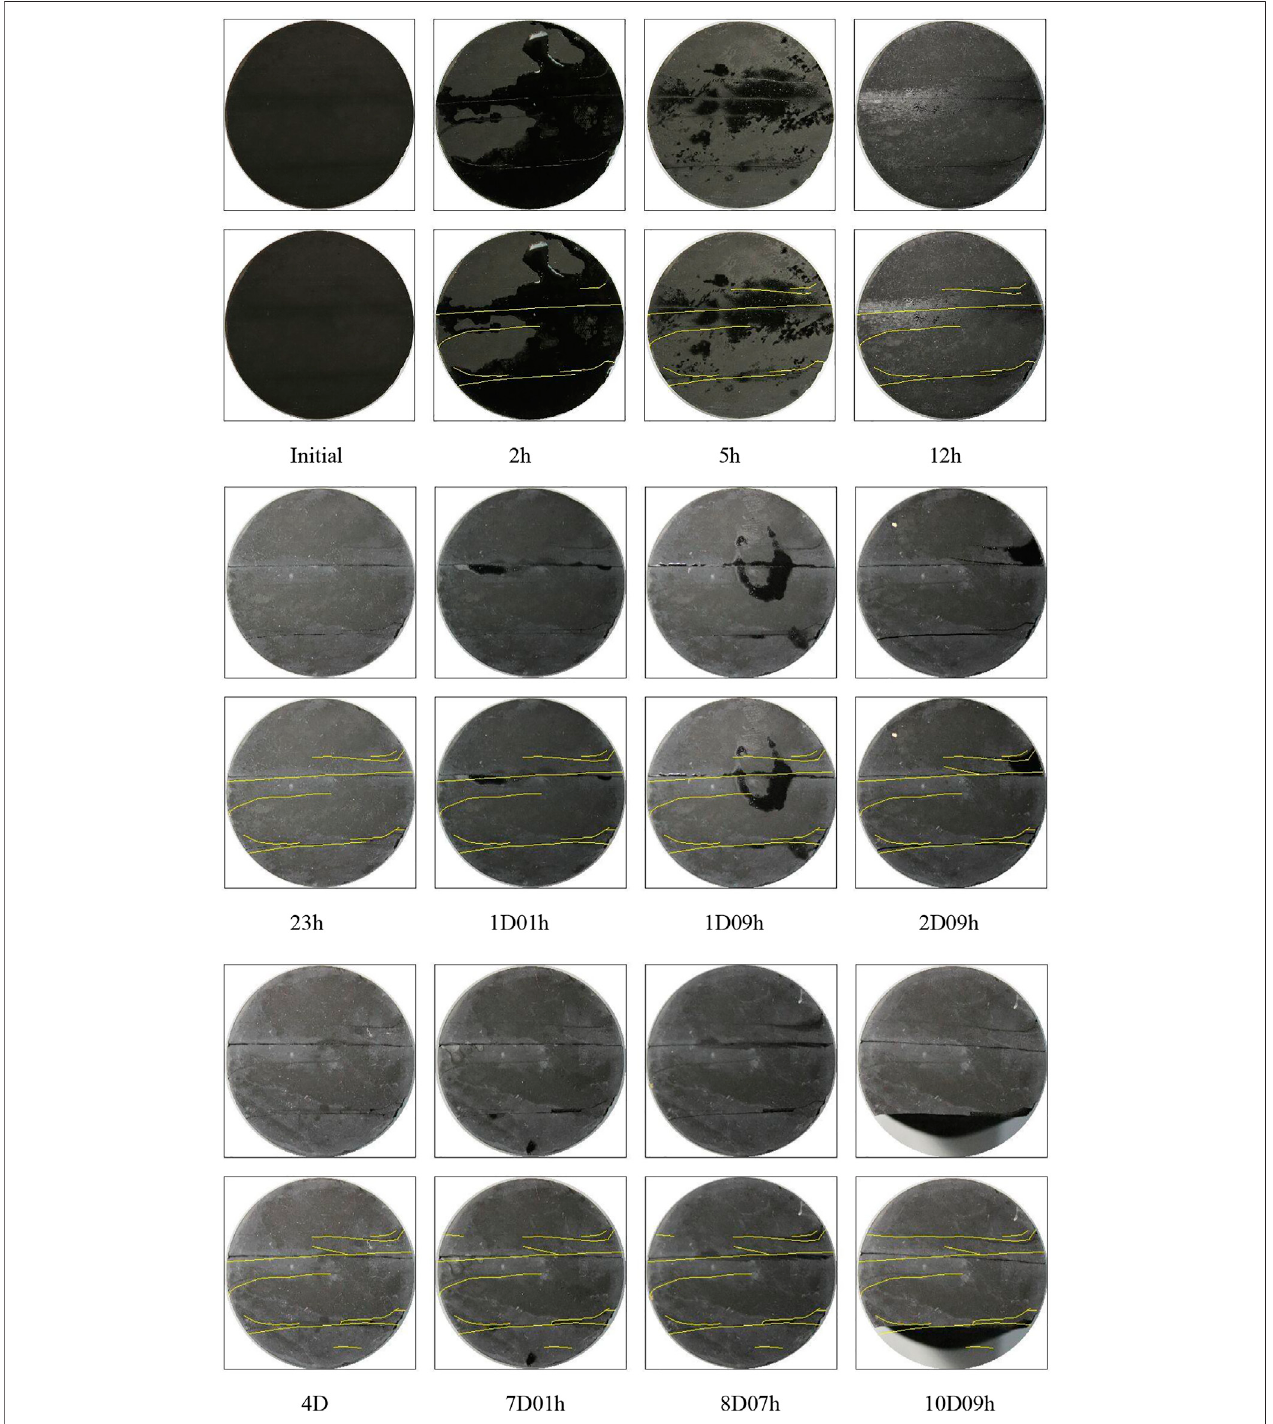
FIGURE 4 | Crack evolution process in fracturing fl uid (lower face of J-2-3) .